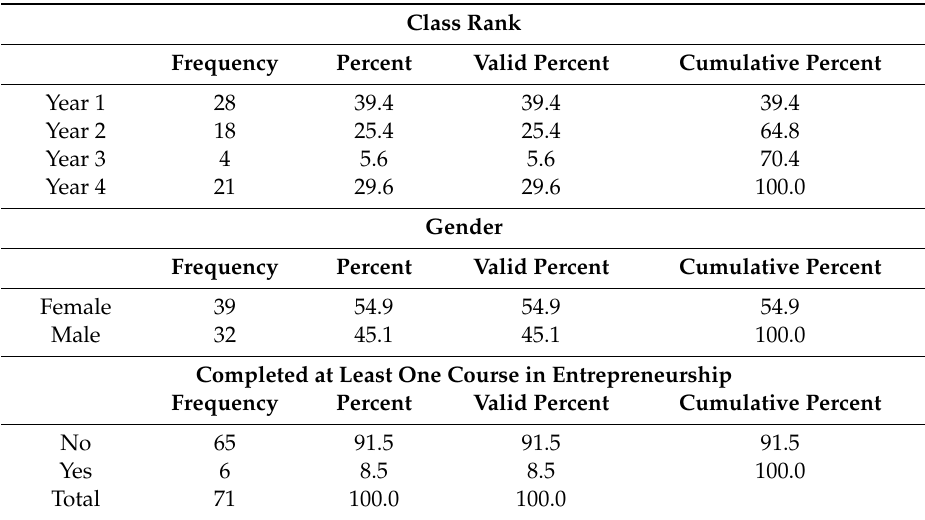
Table 2. Frequencies of covariate measures for Hackathon event (class rank, gender).